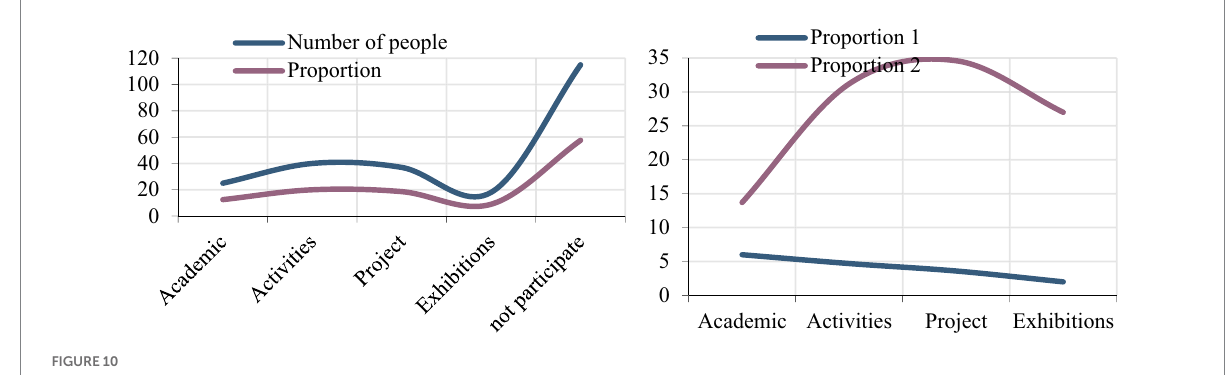
FIGURE 10 Analysis of international exchange and